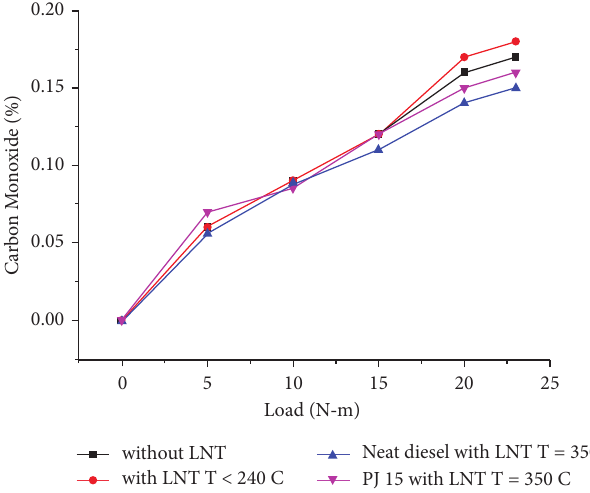
Figure 16: CO emission for Diesel and PJ 15 with